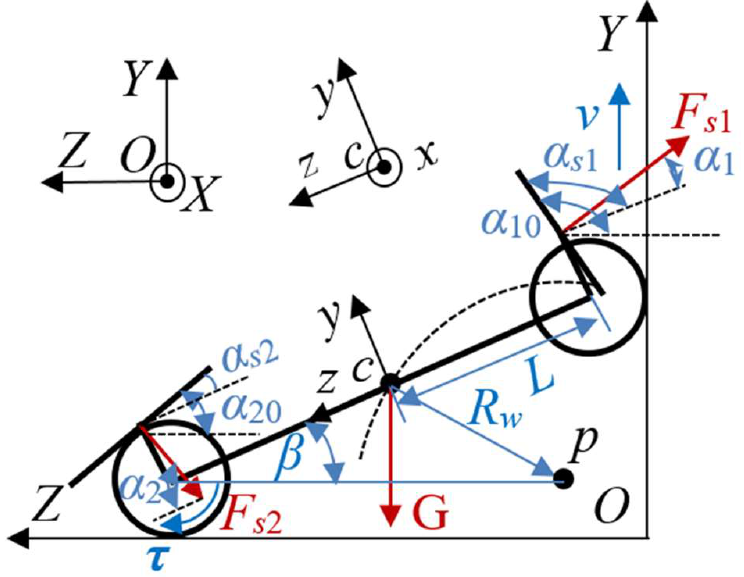
Figure 3. Kinematics model of DP-Climb internal transition. Assume that the longitudinal and lateral slips of the robot are not considered under pure rolling conditions. It is assumed that (1) the body of DP-Climb is rigid and wheel deformation is neglected; (2) the contact wall of the robot is solid and wall deformation is neglected, and the four wheels are always in vertical contact with the contact surface, and there is only one contact point between each wheel and the surface; (3) the gravity distribution of the contact points between wheels and the surface is uniform; and (4) the robot is in a stable motion